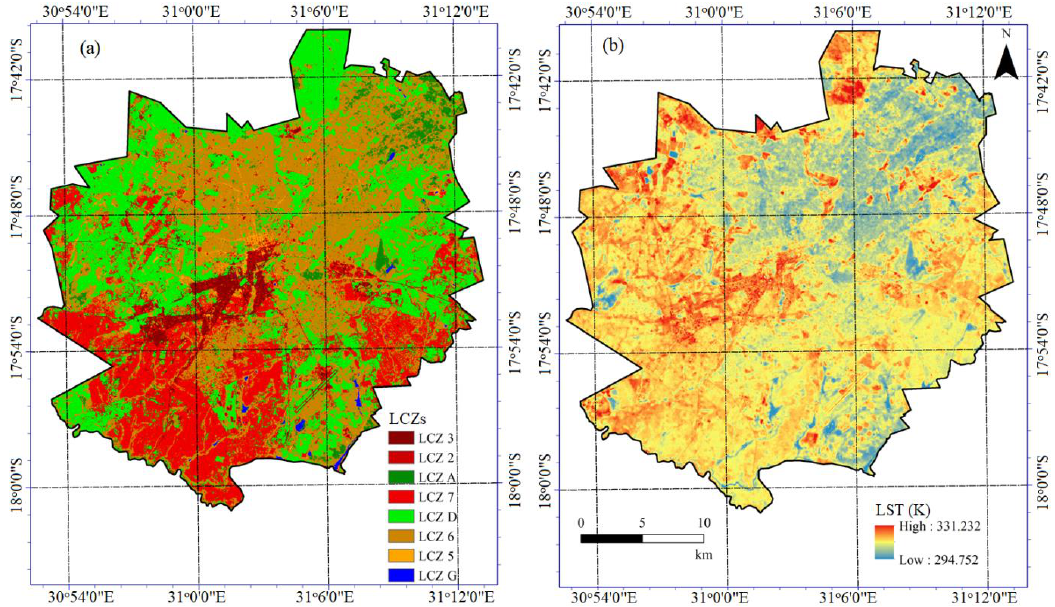
Appl. Sci. 2022 , 12 , x FOR PEER REVIEW Figure 4. LCZ map for Harare ( a ) and derived LST spatial structure ( b ). Figure 4. LCZ map for Harare ( a ) and derived LST spatial structure ( b ).